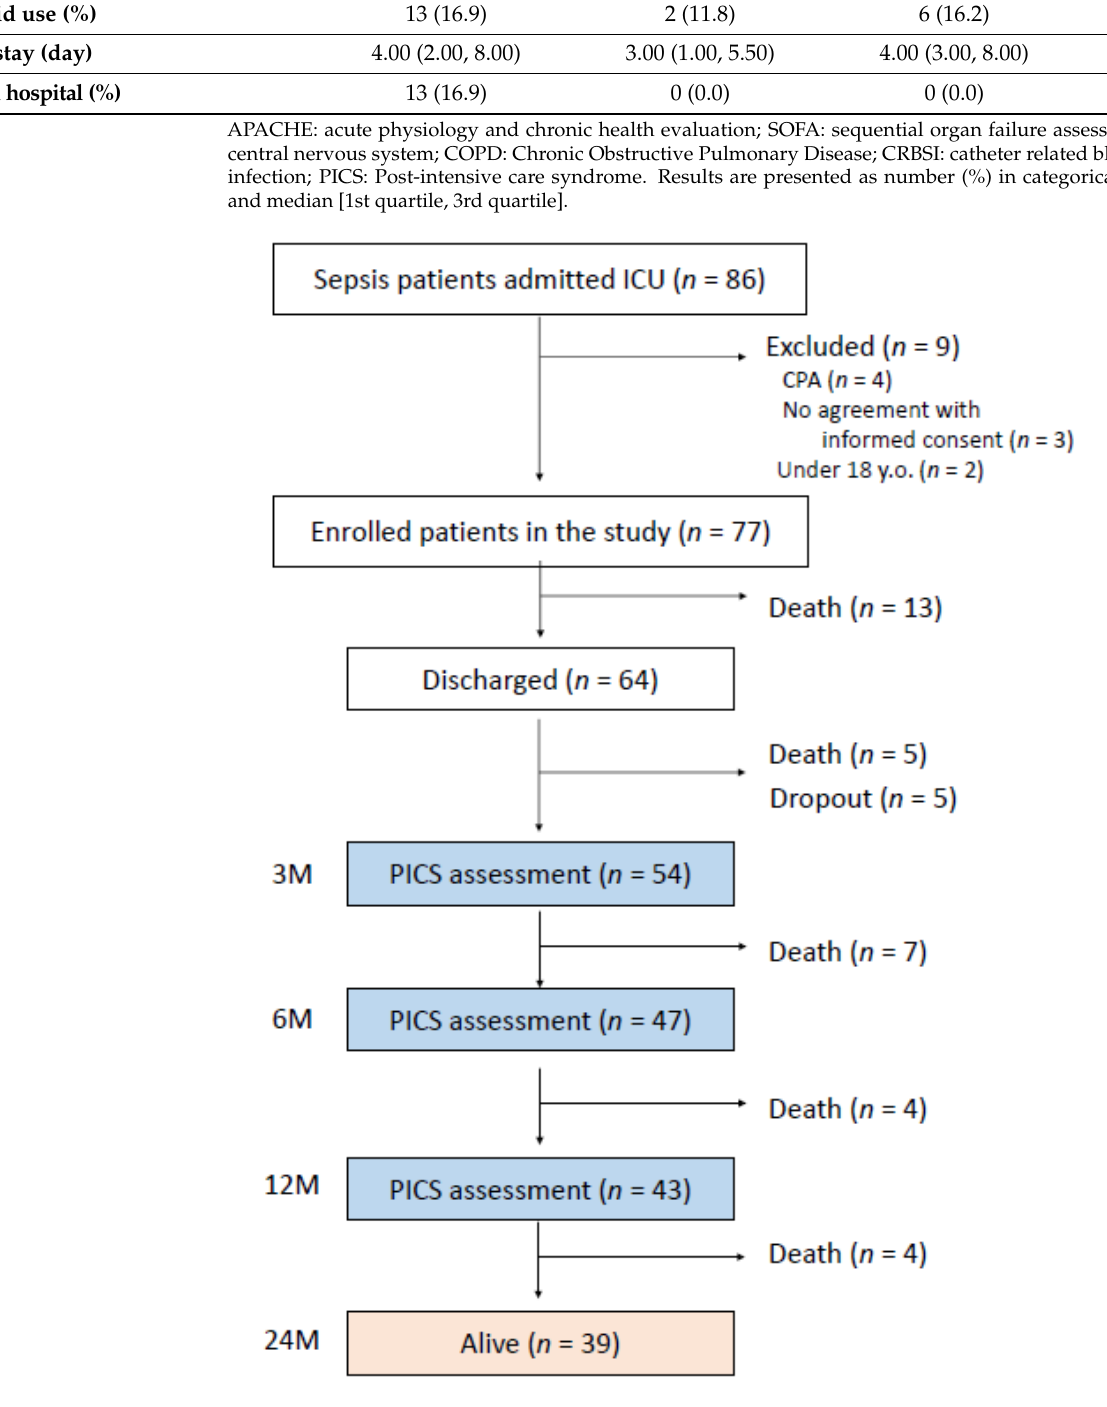
Figure 1. Flowchart of participant enrollment in the study. PICS: post-intensive care syndrome; CPA: cardiopulmonary arrest.